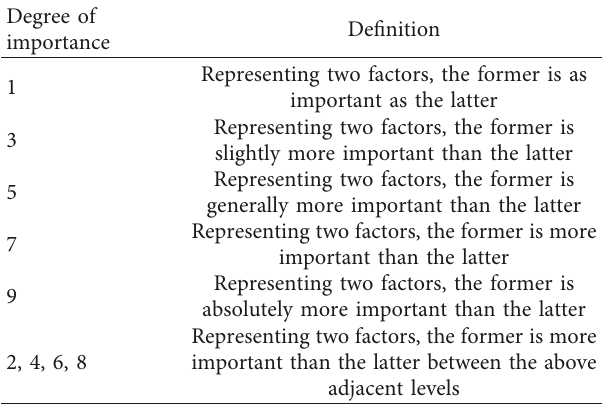
Table 4: 9-scale